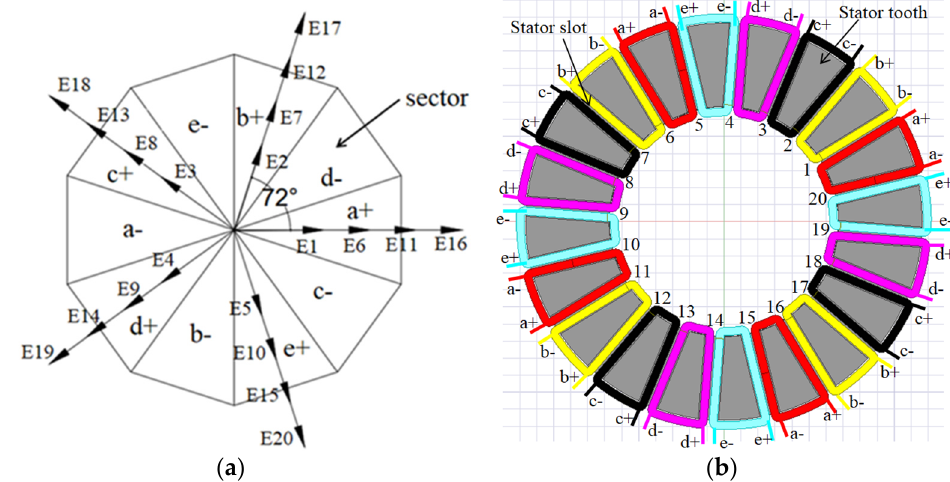
Figure 7. Five-phase stator winding configuration. ( a ) Star of slot, ( b ) armature winding arrangement in the stator slot.